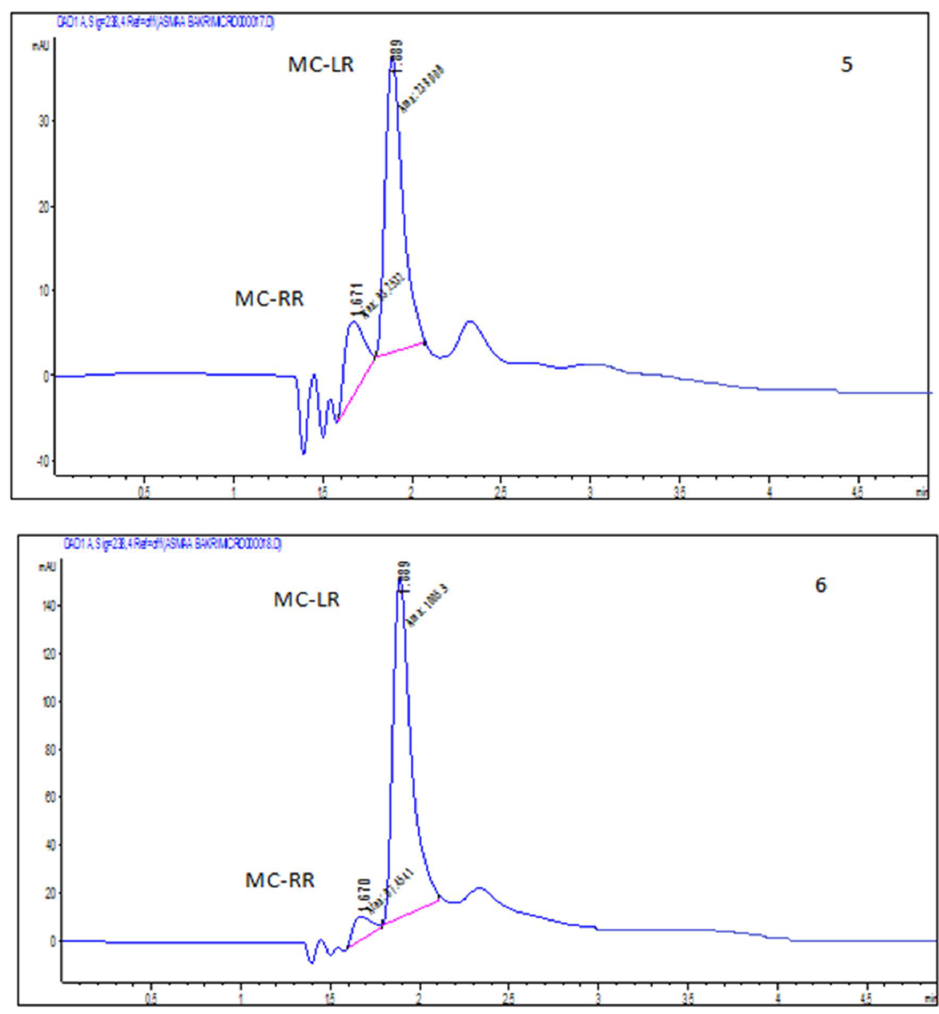
Figure 3. HPLC profile of accumulated MCs from E. sativa (5) and L. sativa (6) collected from the same site that were previously irrigated with polluted water.